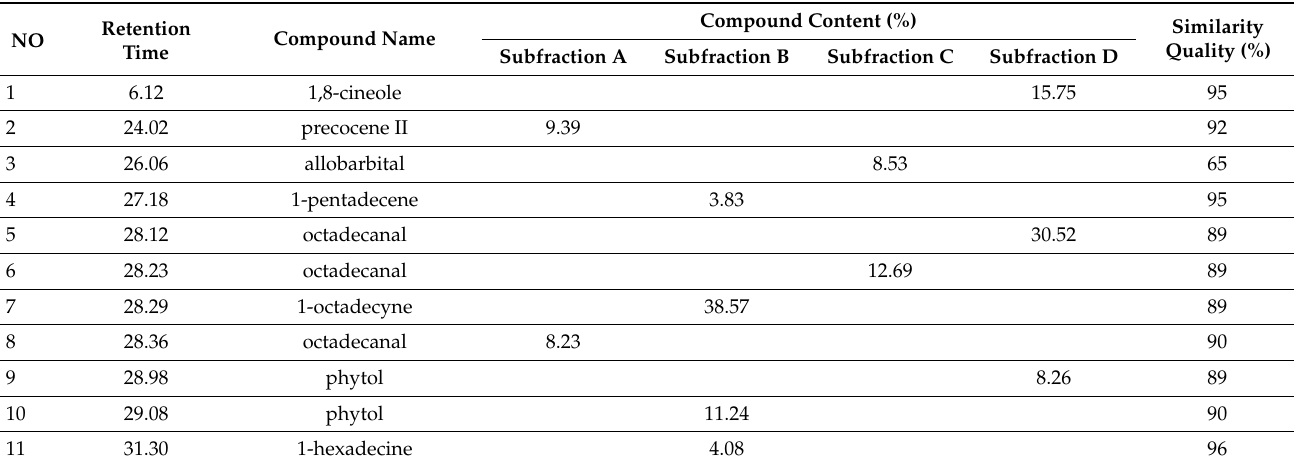
Table 2. Major compounds identified in the A. conyzoides ethyl acetate subfraction A, B, C, D extract by GC-MS.